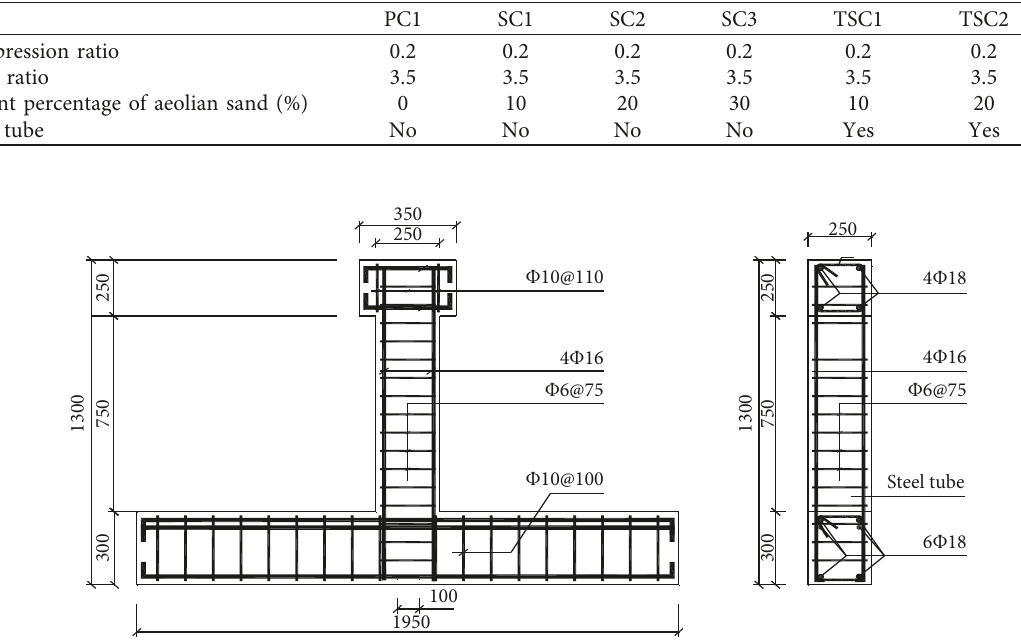
Figure 1: Size and reinforcement of the specimens PC1, SC1, SC2, and SC3.